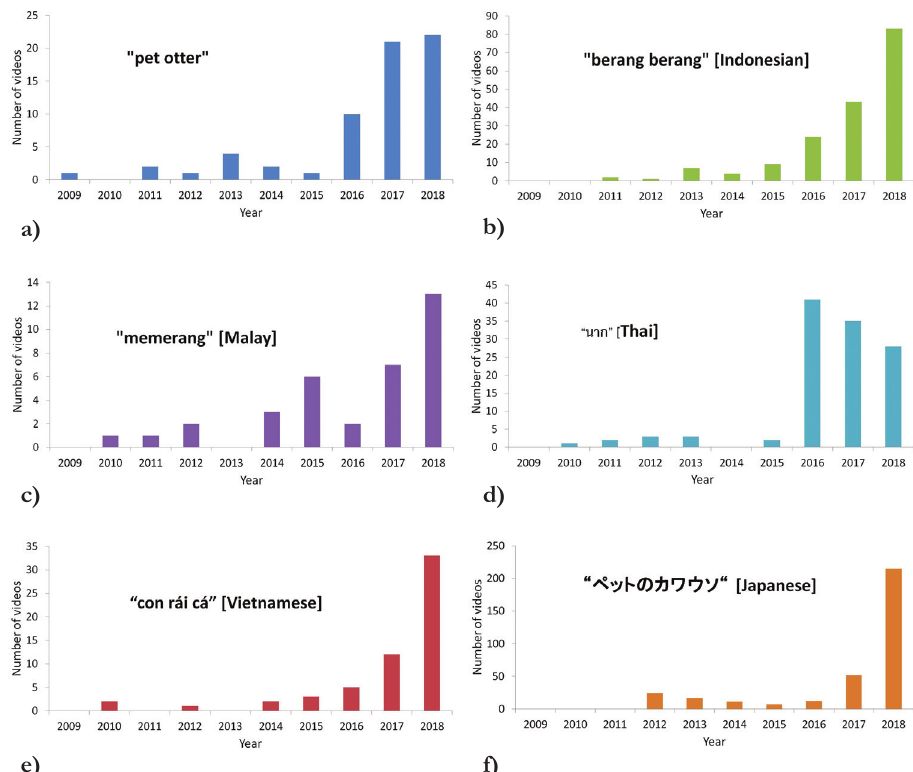
Figure 1. Number of pet otter videos (including reposted videos) published per year for a English lan- guage b Indonesian c Malaysian d Thai e Vietnamese and f Japanese search terms. Note that some videos appeared under more than one search term (e.g. many of the Japanese videos appeared under both English and Japanese translations of “pet otter”), and that the numbers published in 2018 are an underestimate since they did not include videos published in December of that